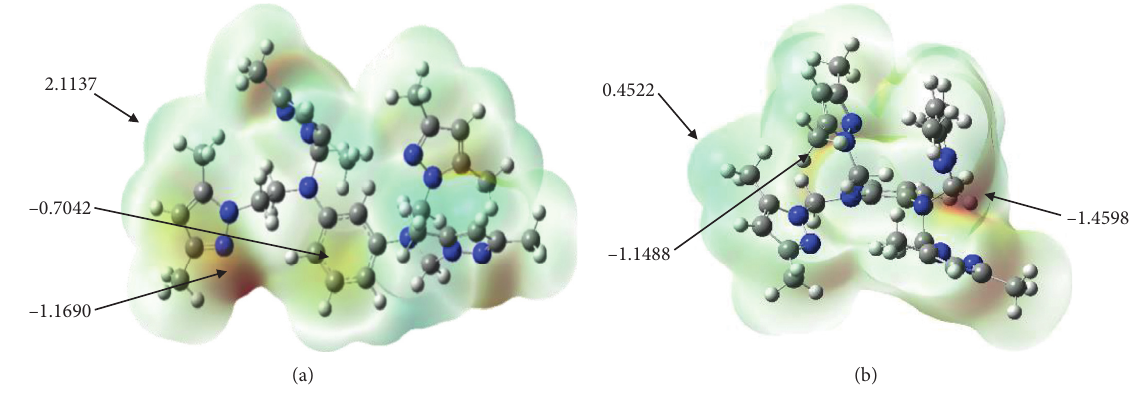
Figure 6: MEP surfaces presentation for the compounds 12 (a) and 13 (b). Table 3: Physicochemical properties of the most potent antibacterial pyrazole derivatives and the antibiotic control streptomycin.